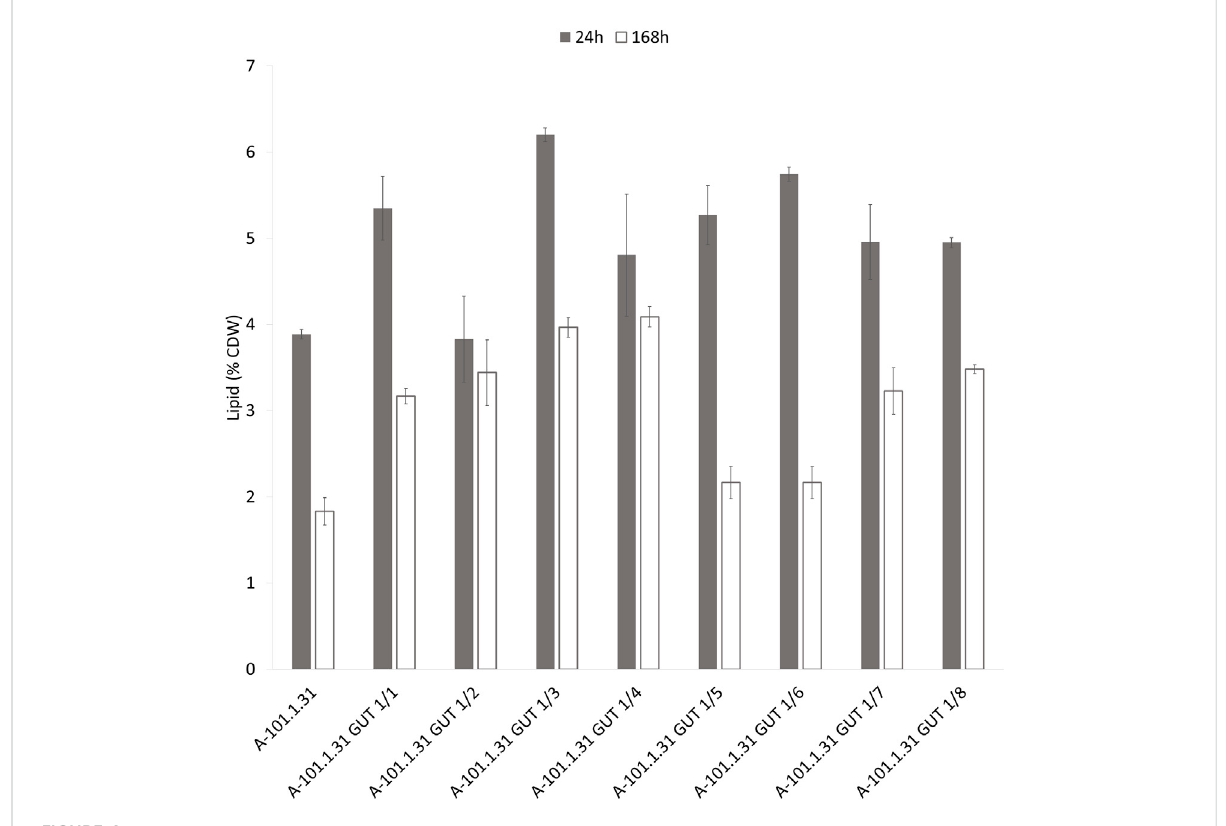
FIGURE 4 Lipid content of Y. lipolytica biomass (WT and GUT1 transformants) during kynurenic acid production in batch bioreactor cultures on waste glycerol ( ■ ) 24 h of the culture and ( □ ) 168 h of the